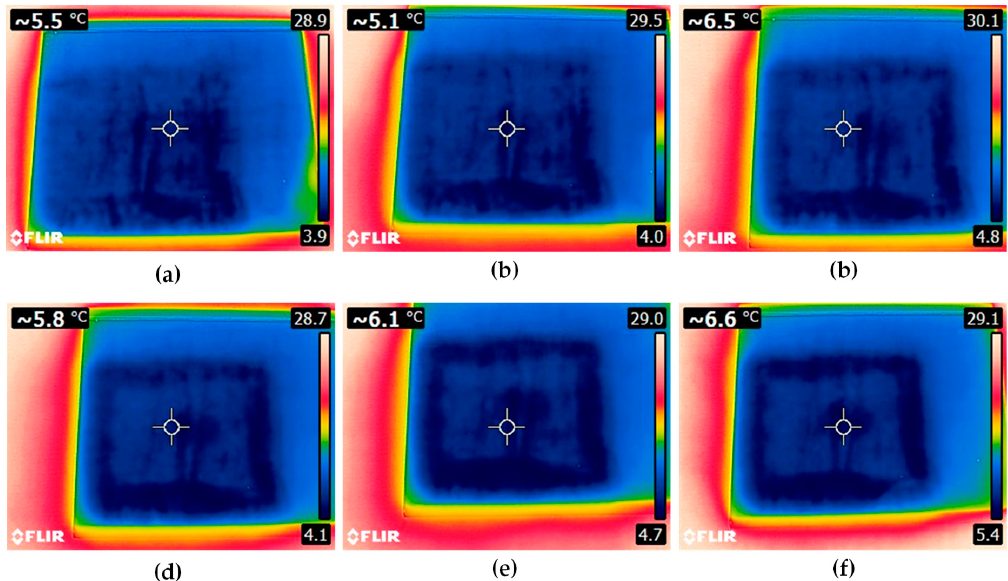
Figure 12. View of the sample: ( a ) at the beginning of temperature equilibration process, ( b ) 30 s at 30 ◦ C, ( c ) 60 s at 30 ◦ C, ( d ) 90 s at 30 ◦ C, ( e ) 120 s at 30 ◦ C, ( f ) 150 s at 30 ◦ C.